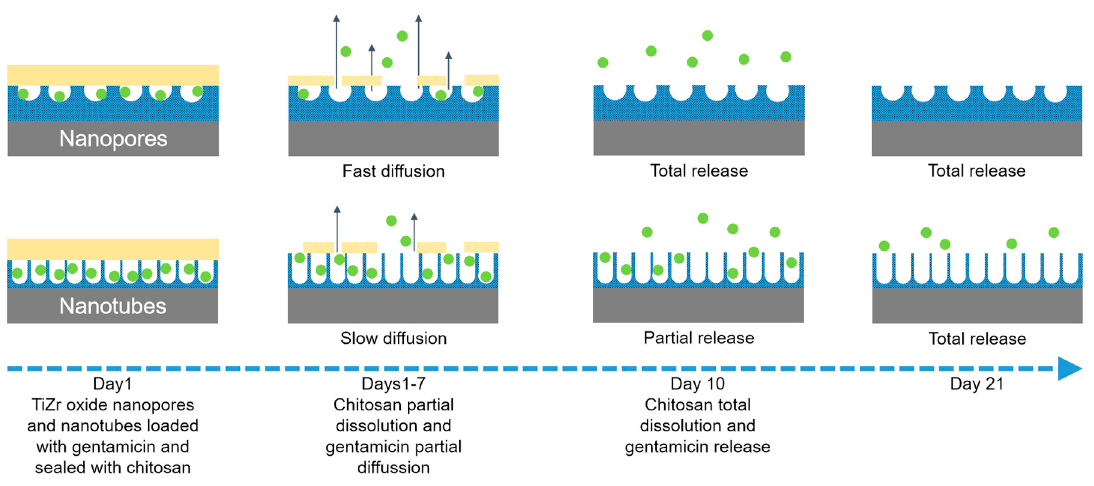
Figure 4. Schematic representation of the obtained coated nanostructures and drug release over